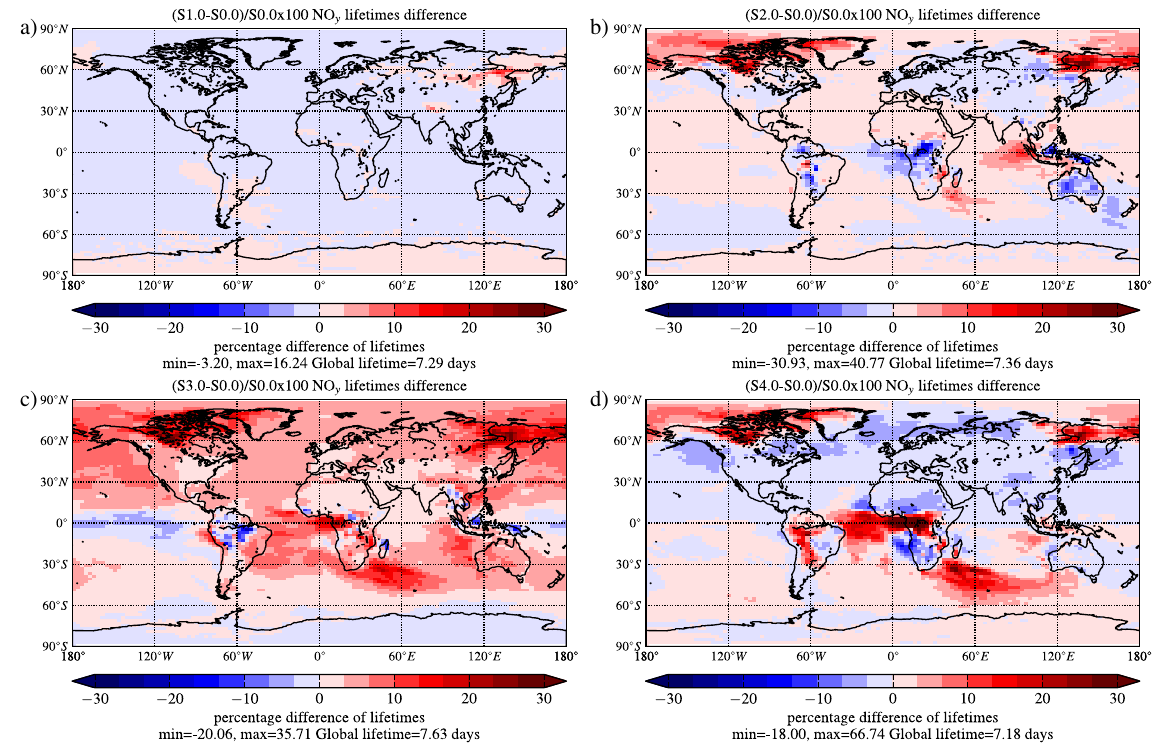
Figure 11. Computed annual mean tropospheric NO y lifetime differences between the base case scenario (S0.0) and S1.0 (a) , S2.0 (b) , S3.0 (c) and S4.0 (d) , computed by reference to S0.0. The color bar ranges from − 30 to 30%. The minimum and maximum local lifetime percentage changes as well as the global lifetime are printed below each panel. Table 6. Calculated annual mean tropospheric lifetimes of pollutants for all the simulations